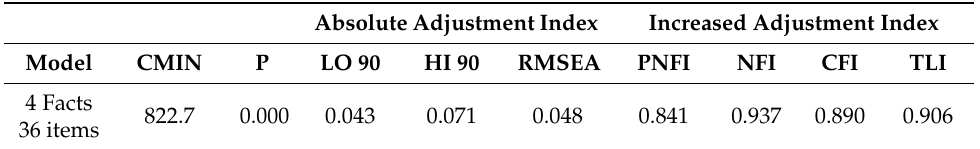
Table 1. Adjustment index of the model of the Adolescent Perception of Religious Education (APREQ)